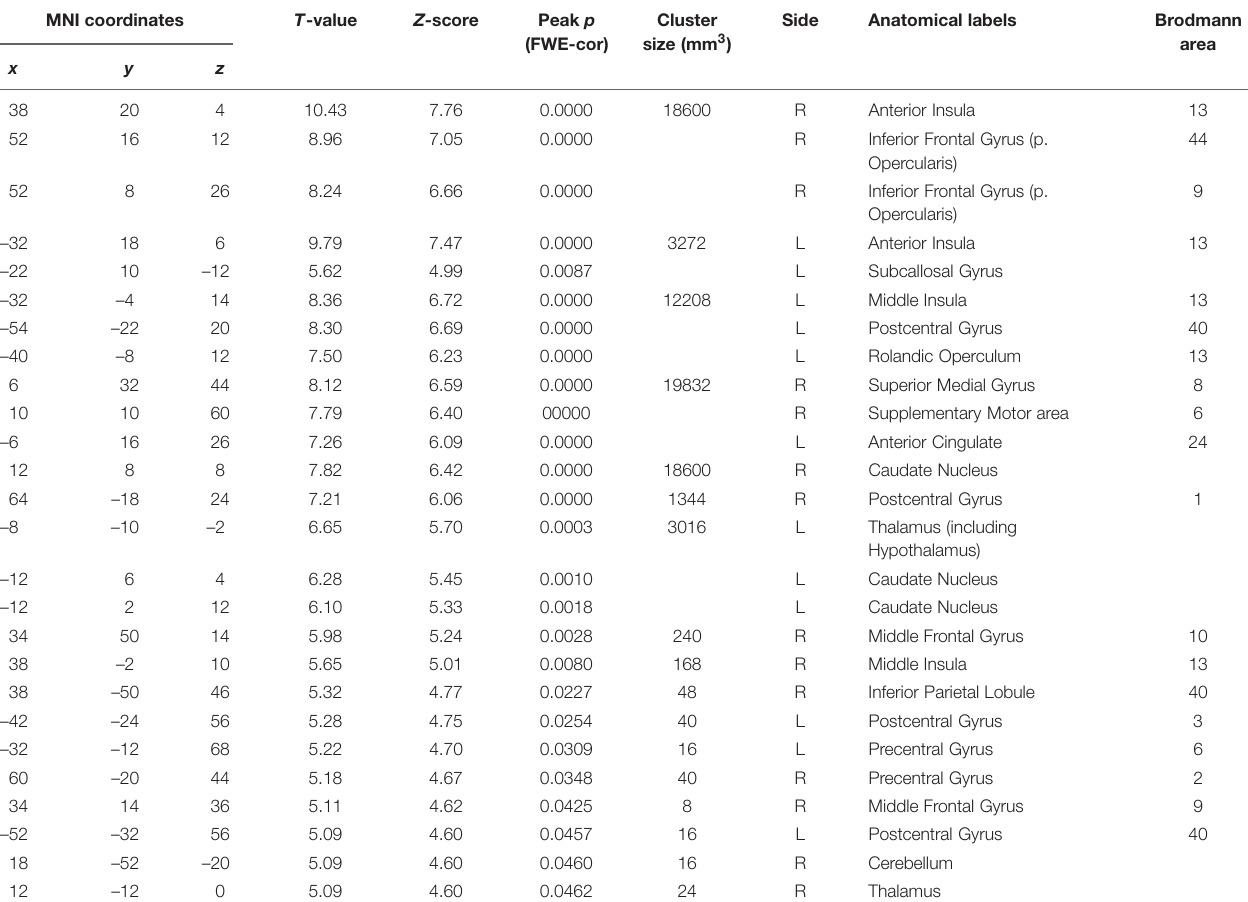
TABLE 4 | The peak coordinates displayed significant responses by the comparison [2 ×